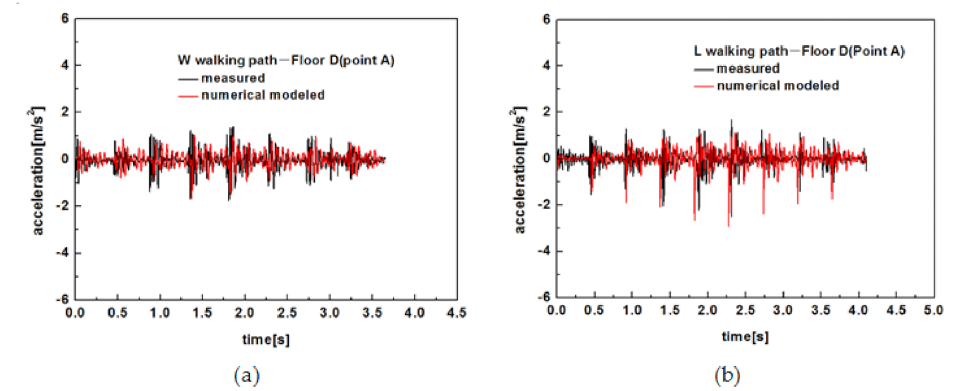
Figure 21. Acceleration responses at points A for Floor D: ( a ) W path and ( b ) L